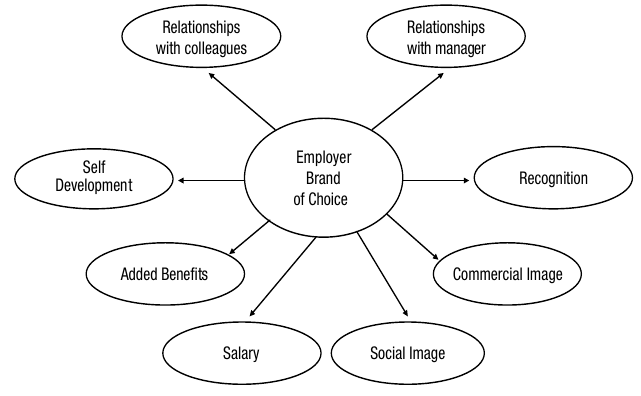
Fig. 1. The conceptual